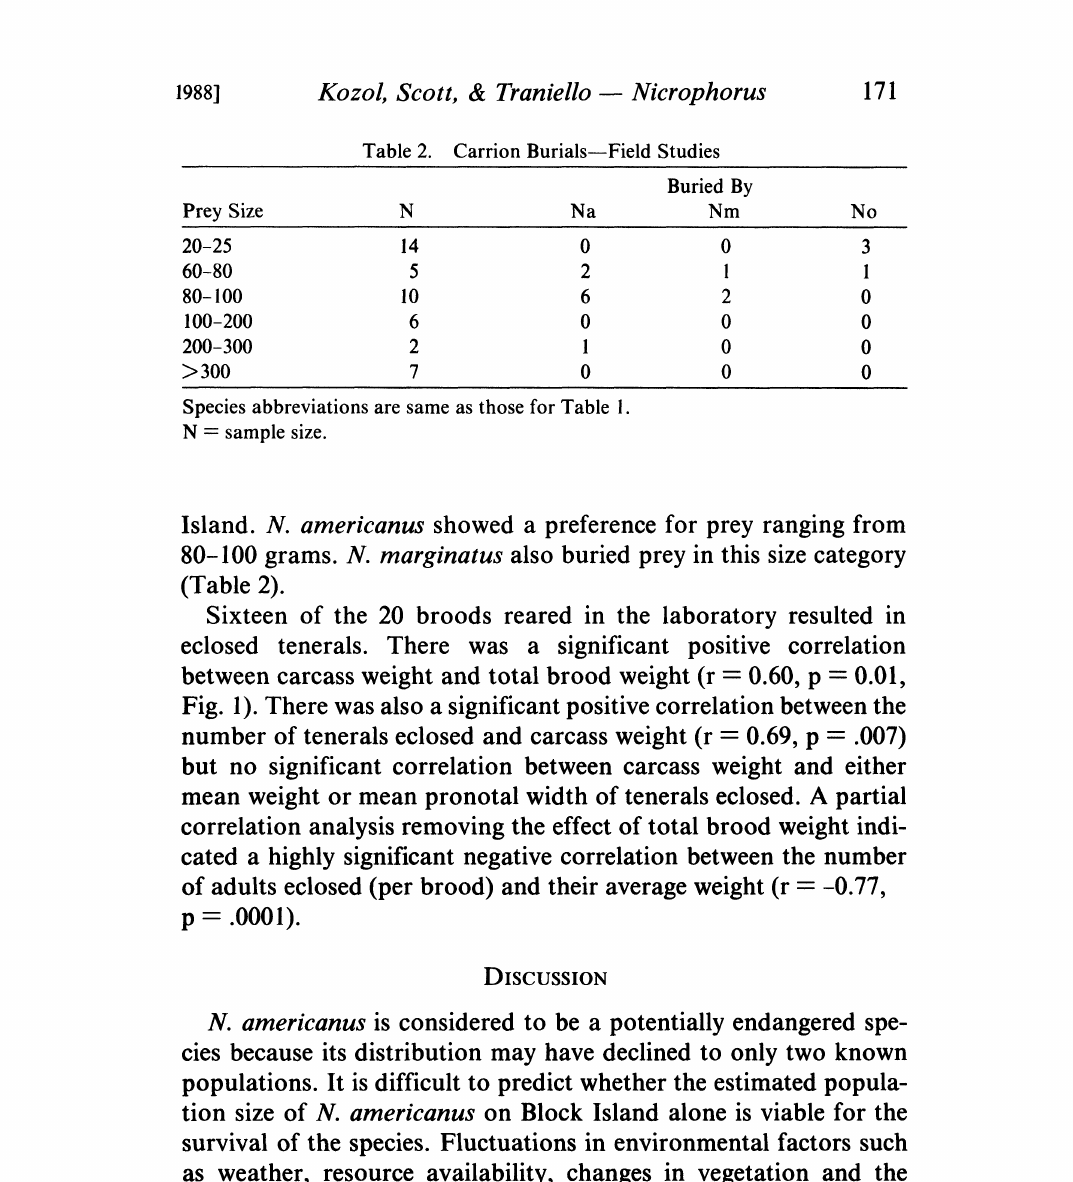
Table 2. Carrion Burials--Field Studies